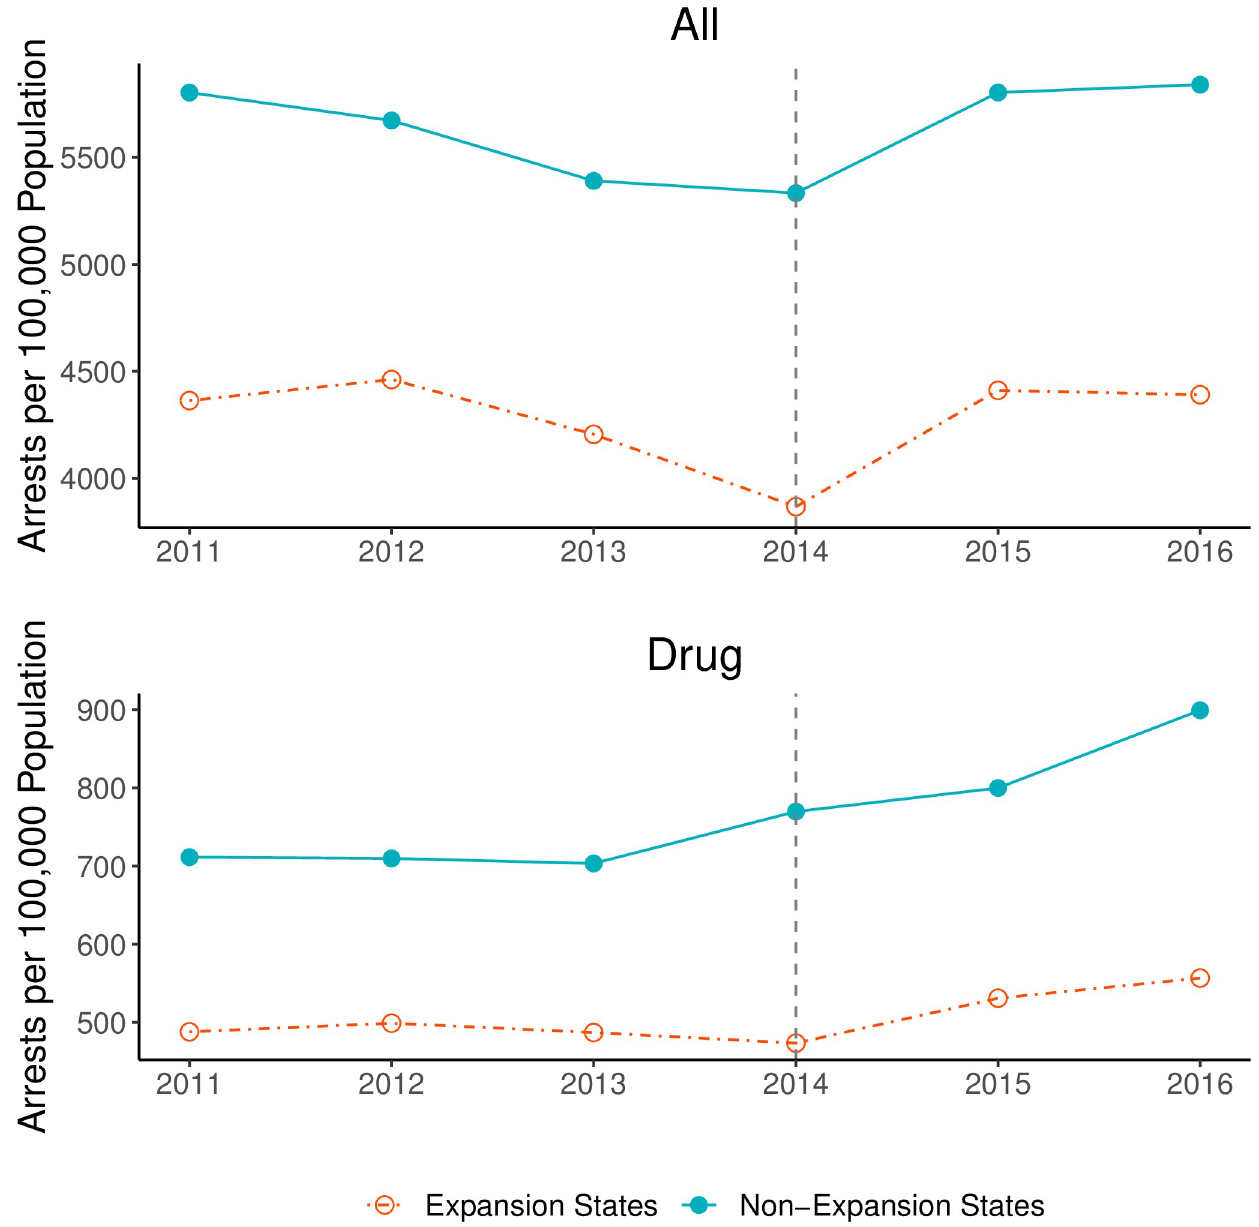
Fig 1. Rates of all arrests and drug arrests for analysis years, 2011–2016. We plot the total and drug arrest rates per 100,000 residents in counties, unadjusted by covariates and exclude areas that expanded Medicaid before or after 2014. A vertical line indicates the first year ACA Medicaid expansion took effect